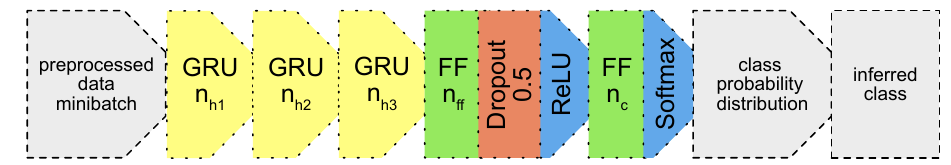
Figure 3. GRU DNN with three RNN layers with gated recurrent unit architectures at its core. FF marks a typical fully-connected (dense) layer. n is number of hidden units in the respective layers.